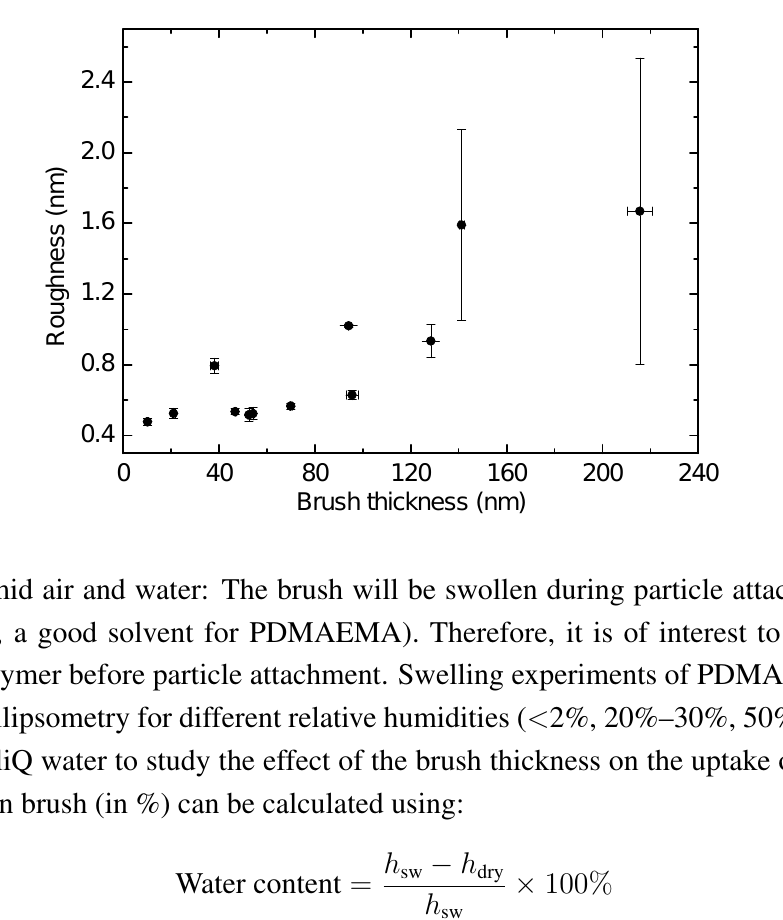
Figure 2. Dependence of AFM surface roughness recorded at ambient conditions on ambient brush thickness (as measured by